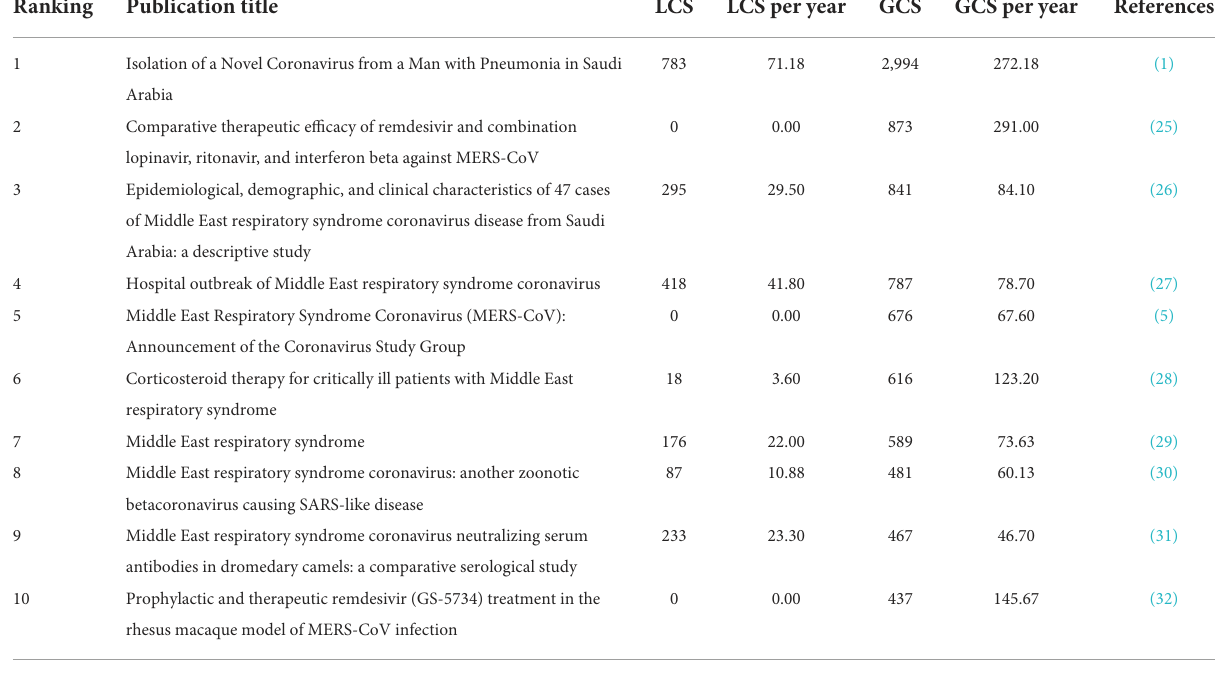
TABLE 2 Top 10 most-cited publications on MERS-CoV according to GCS at the time of